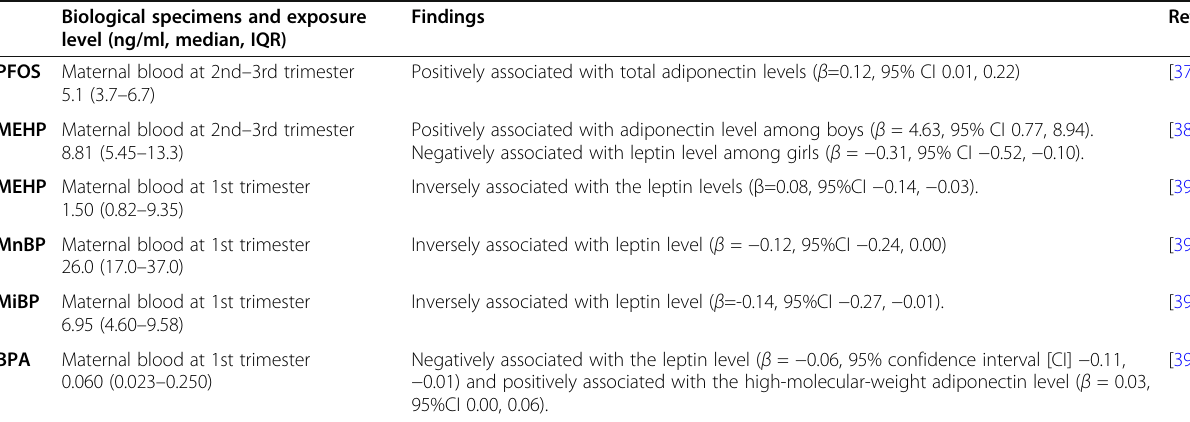
Table 3 Prenatal chemical exposure and association with adipocytokines at birth Biological specimens and exposure level (ng/ml, median, IQR)